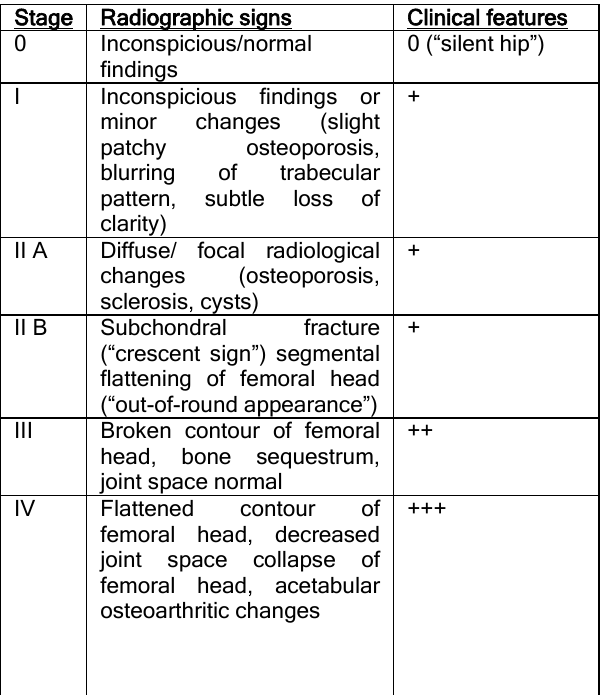
Fig. 1 Technique for performing core decompression.